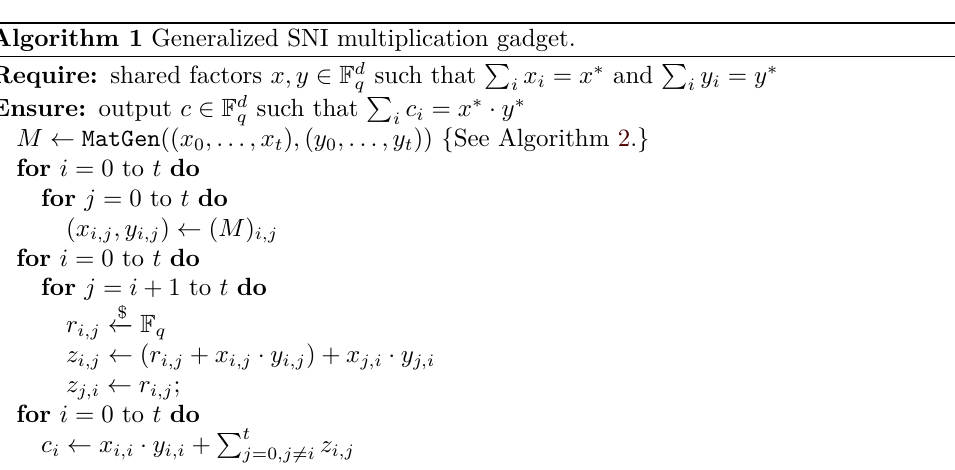
Algorithm 1 Generalized SNI multiplication gadget.